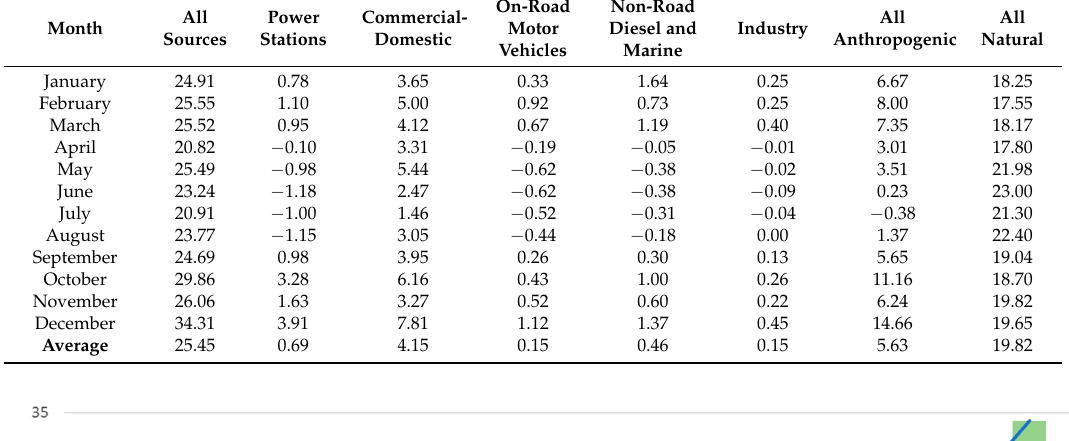
Table A5. Monthly average of daily maximum 1-hour predicted ozone concentration (ppb) in the Newcastle region for different months in 2008 under various emission scenarios.